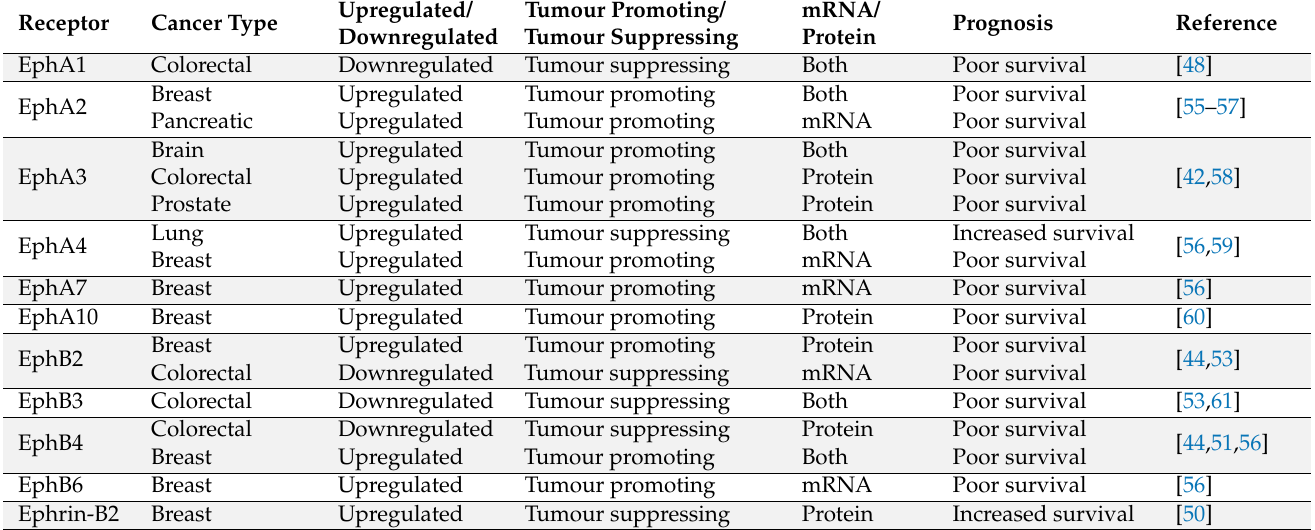
Table 1. Expression of Eph receptors in cancers and association with tumour progression and patient